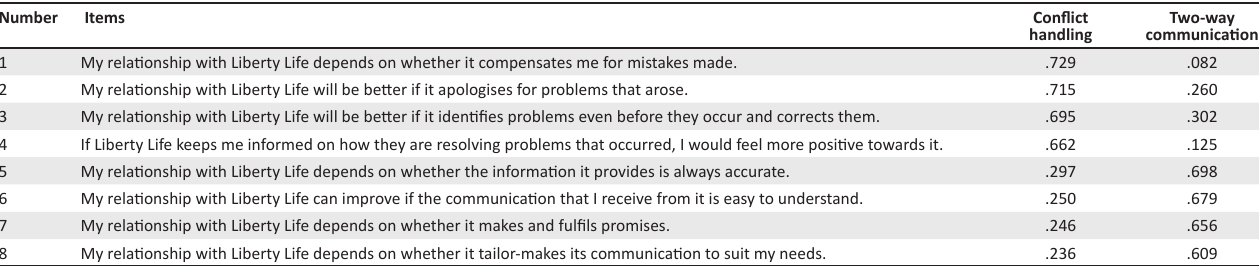
TABLE 2: Exploratory rotated factor analysis